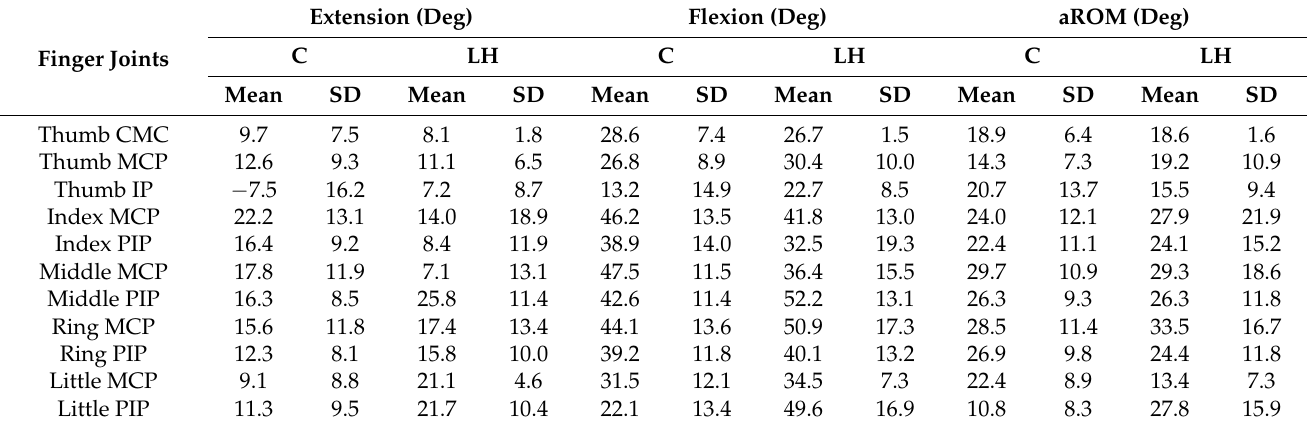
Table 6. Range of motion (ROM) during the sixteen activities (control and left